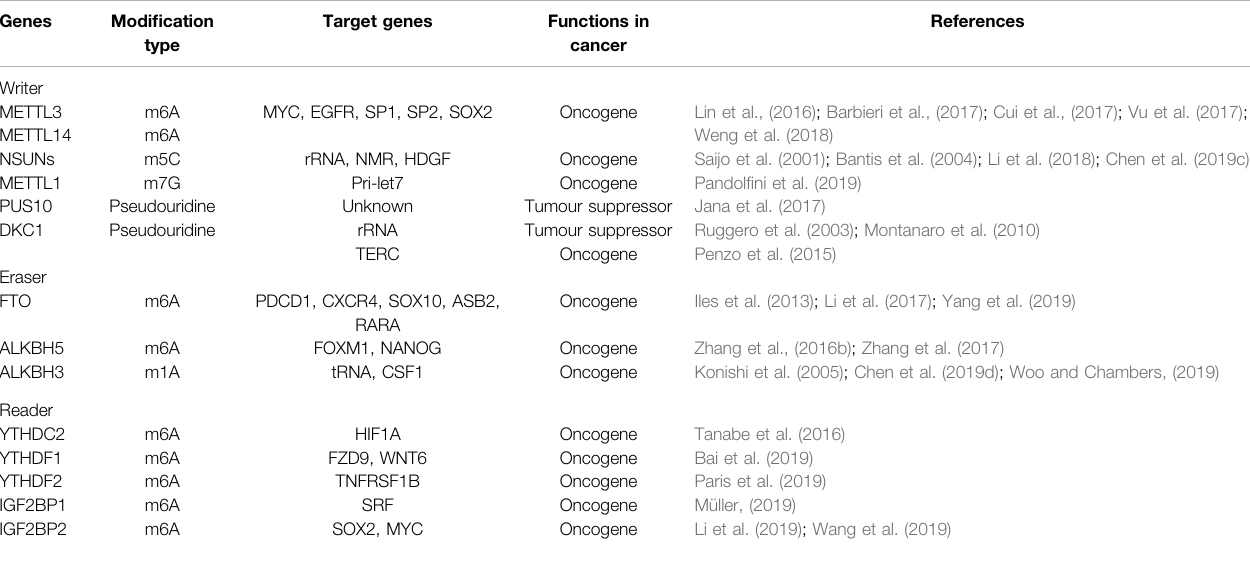
TABLE 1 | The main factors of RNA modi fi